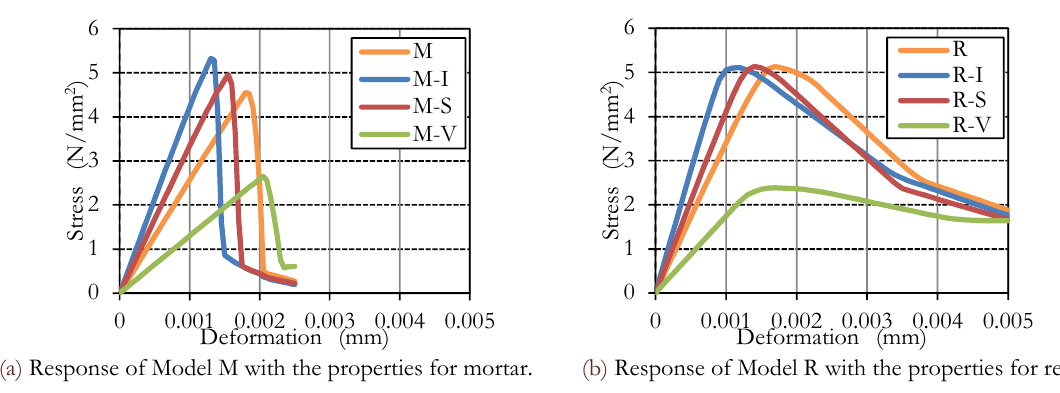
Figure 6: Analyzed stress-deformation response for monolithic models.